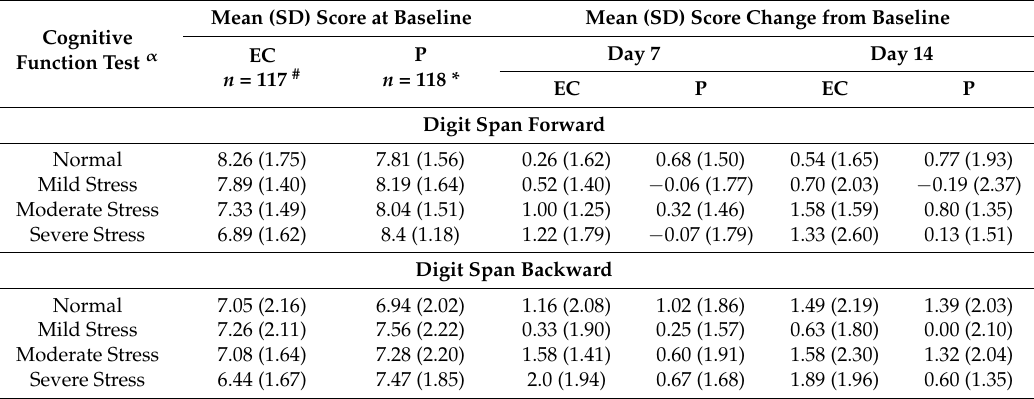
Table 4. Baseline and change scores of WAIS Digit Span Forward and Backward by Participant Stress Levels ˆ in Essence of Chicken (EC) and Placebo (P)